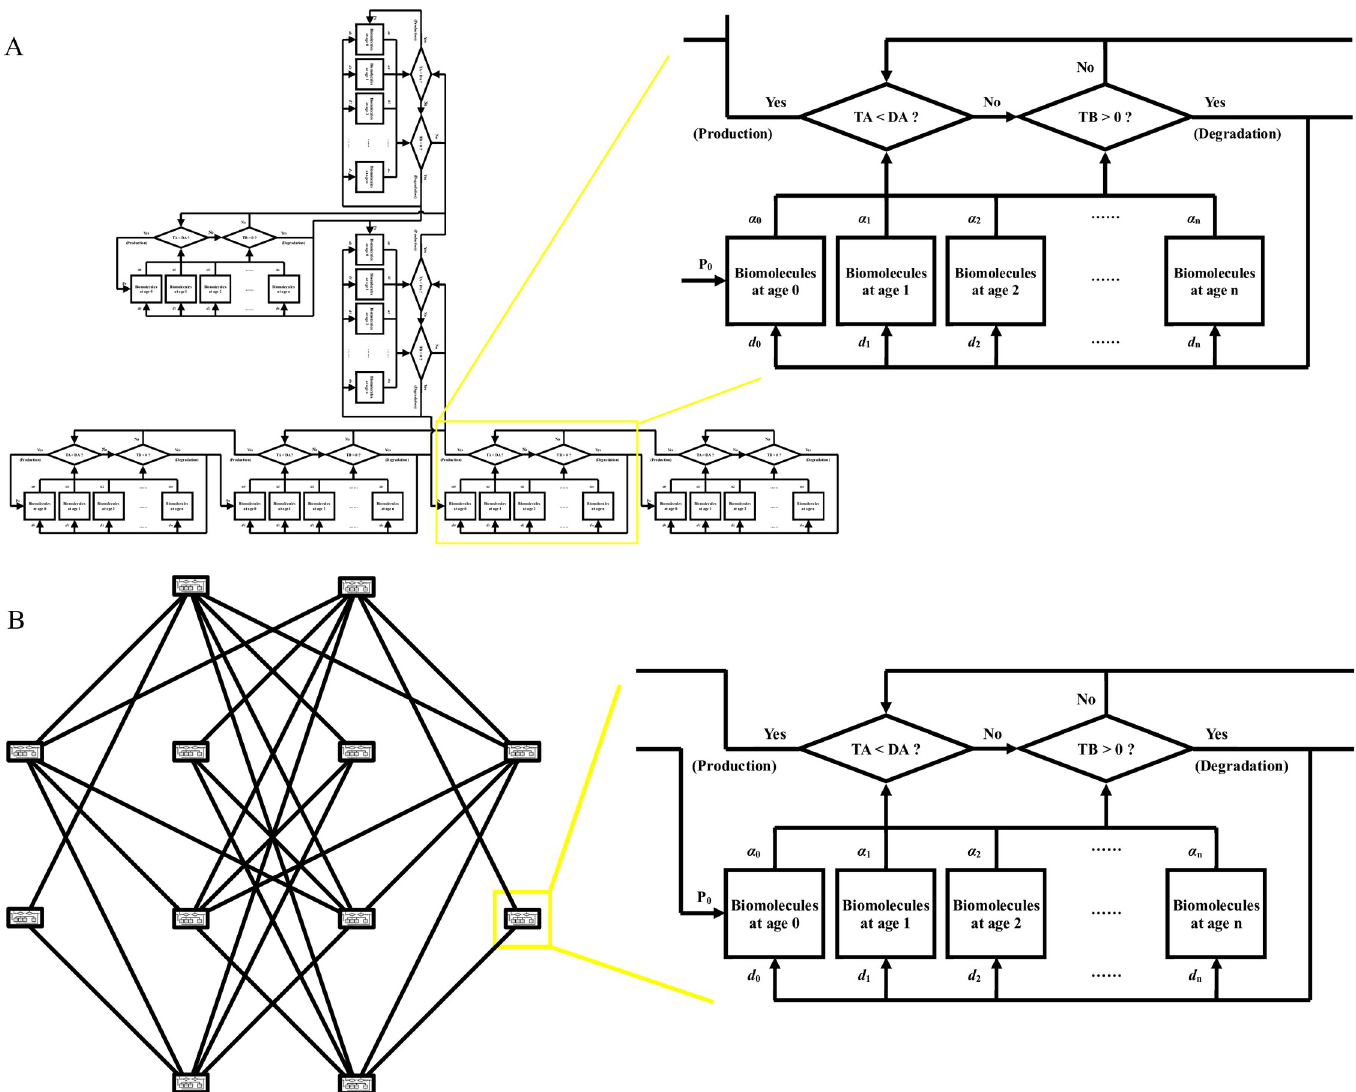
Fig 7. Chain and web of the present model. TB represents the total abundance of biomolecules at all biomolecular ages. TA represents total biomolecular activity at all biomolecular ages. DA represents the demands for biomolecular activity in the cell. DA is influenced by stimuli from intra- and extracellular environments, and the difference between TA and DA determines the trigger or cessation of biomolecule production. d 0 , d 1 , d 2 , ... , d n are degradation coefficients. α 0 , α 1 , α 2 , ... , α n are activity coefficients. P 0 represents the level of nascent biomolecules per time. (A) Chain of the present model. (B) Web of the present